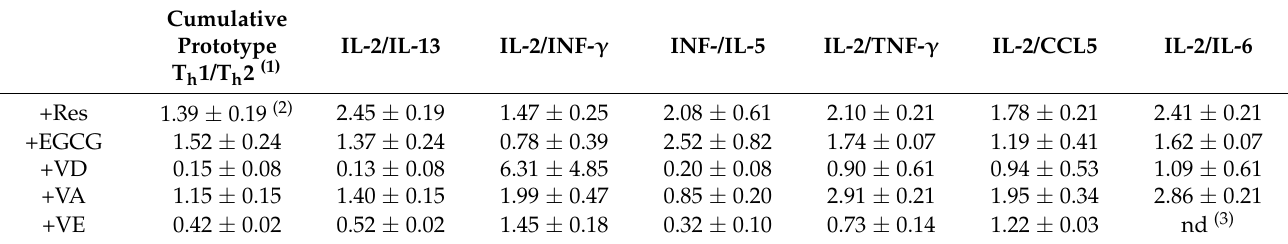
Secreted interleukins and cytokines of PBMCs, which were activated with anti-CD3/CD28 and cultured for 5 days in the presence or absence of indicated substances, were measured (in triplicates). Data were normalized against ‘activated cells’ (which were set as 1). Mean values ± SEM are given ( n = 4). (1) (prototype T h 1: IL-2, INF- γ )/prototype T h 2: IL-5, IL-13). (2) ratio of secreted interleukin